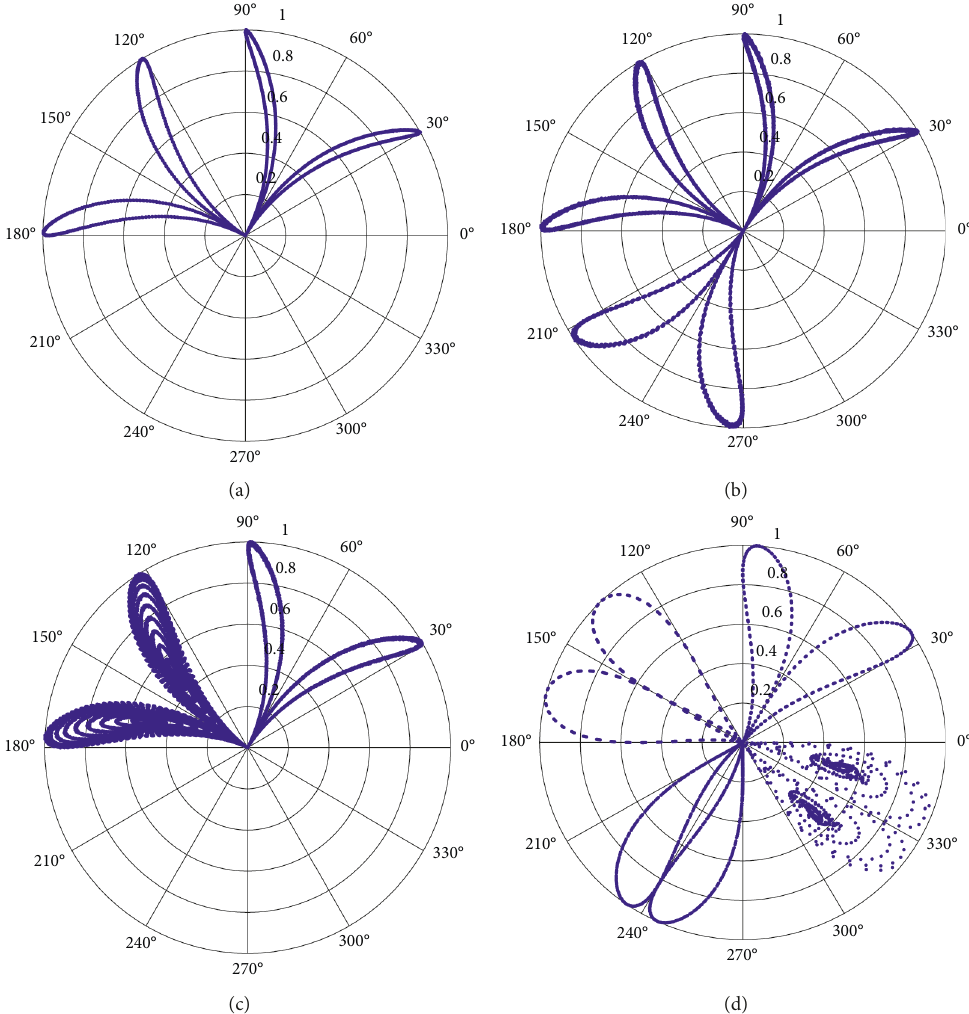
Figure 6: SDP Images of various signal components. (a) SDP image of signal x x 3 ( t ). (d) SDP image of signal x 4 ( t ).